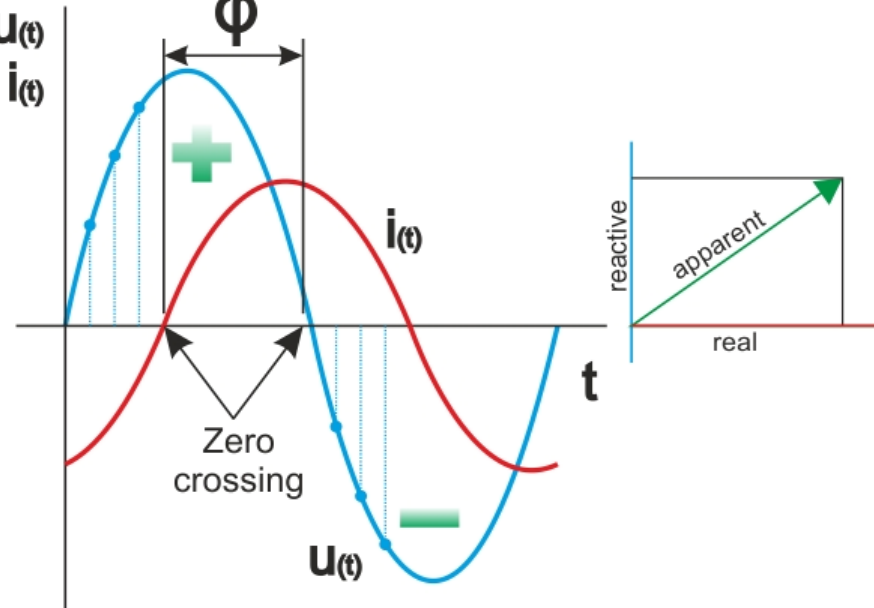
Figure 2. Determining phase shift between current and